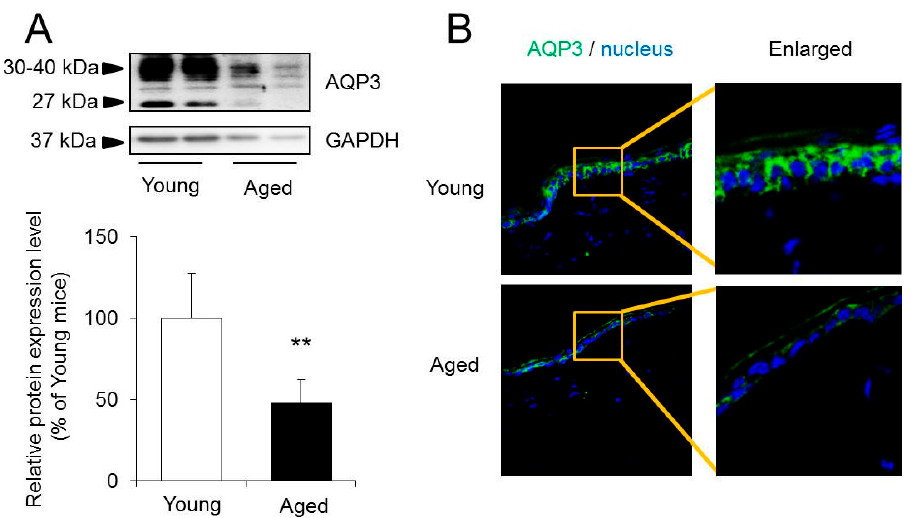
Figure 3. The protein expression level of AQP3 in the skin. The whole skin, containing epidermis and dermis, was harvested from young and aged mice. ( A ) The protein expression level of AQP3 in the skin was measured using western blotting, and normalized to glyceraldehyde-3-phosphate dehydrogenase (GAPDH). Mean levels of AQP3 protein expression of young mice were indicated as 100%. The data represent the means ± SDs for five mice. Student’s t -test: ** p < 0.01 vs. Young mice. ( B ) AQP3 (green) and nuclei (blue) were immunostained.